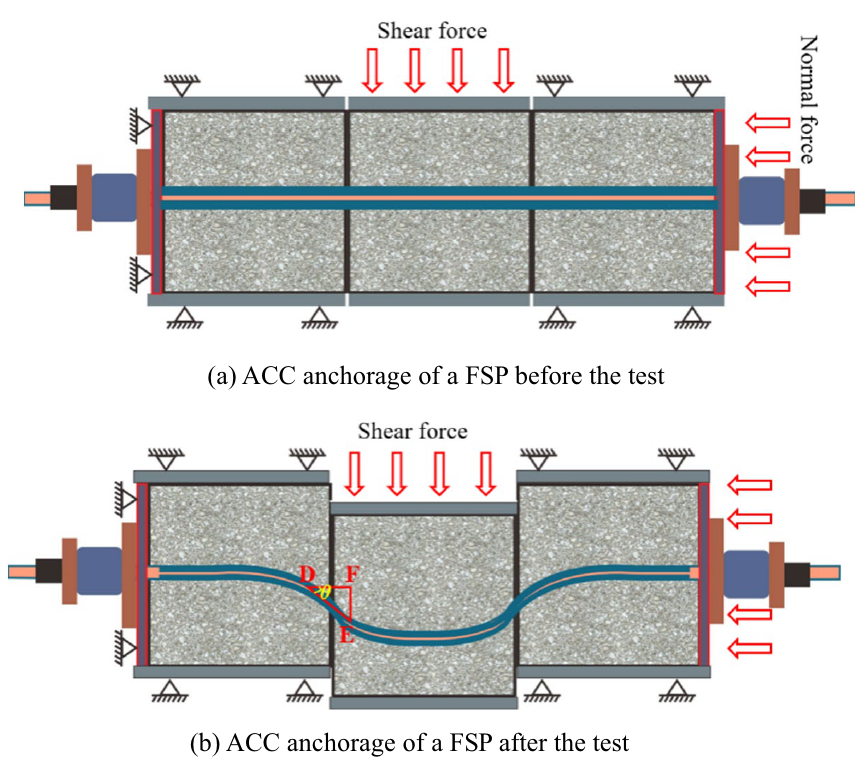
Figure 6. Diagram of the ACC anchorage of a FSP before and after